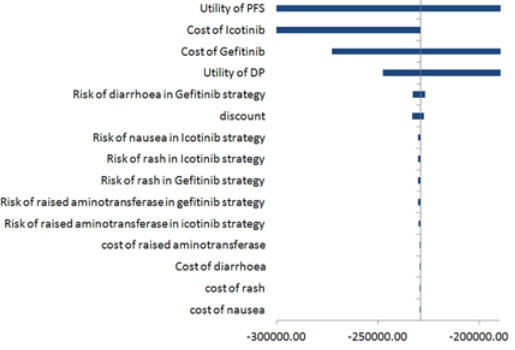
Fig 2. Incremental cost-effective ratio (ICUR) tornado